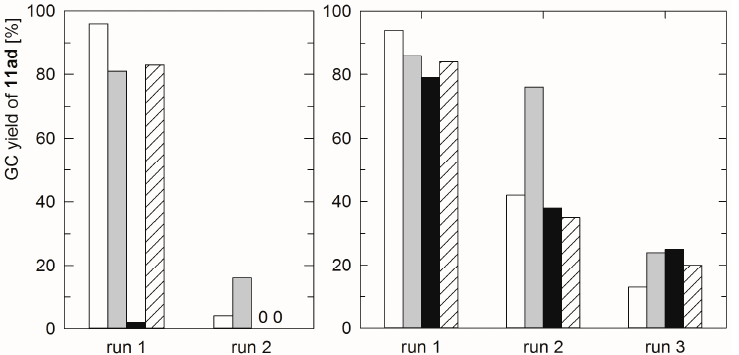
Figure 6. Results of catalytic experiments with fresh and reused catalysts without (left) and with (right) added CuI (5 mol.%): catalyst 5 (white bars), catalyst 6 (grey bars), catalyst 7 (black bars), and catalyst 8 (hatched bars). Conditions: 0.1 mol.% Pd, alkyne 9a (1 equiv.), acyl chloride 10d (1.5 equiv.), triethylamine (5 equiv.), dodecane (1 equiv.; internal standard) in acetonitrile at 50 °C for 2 h.